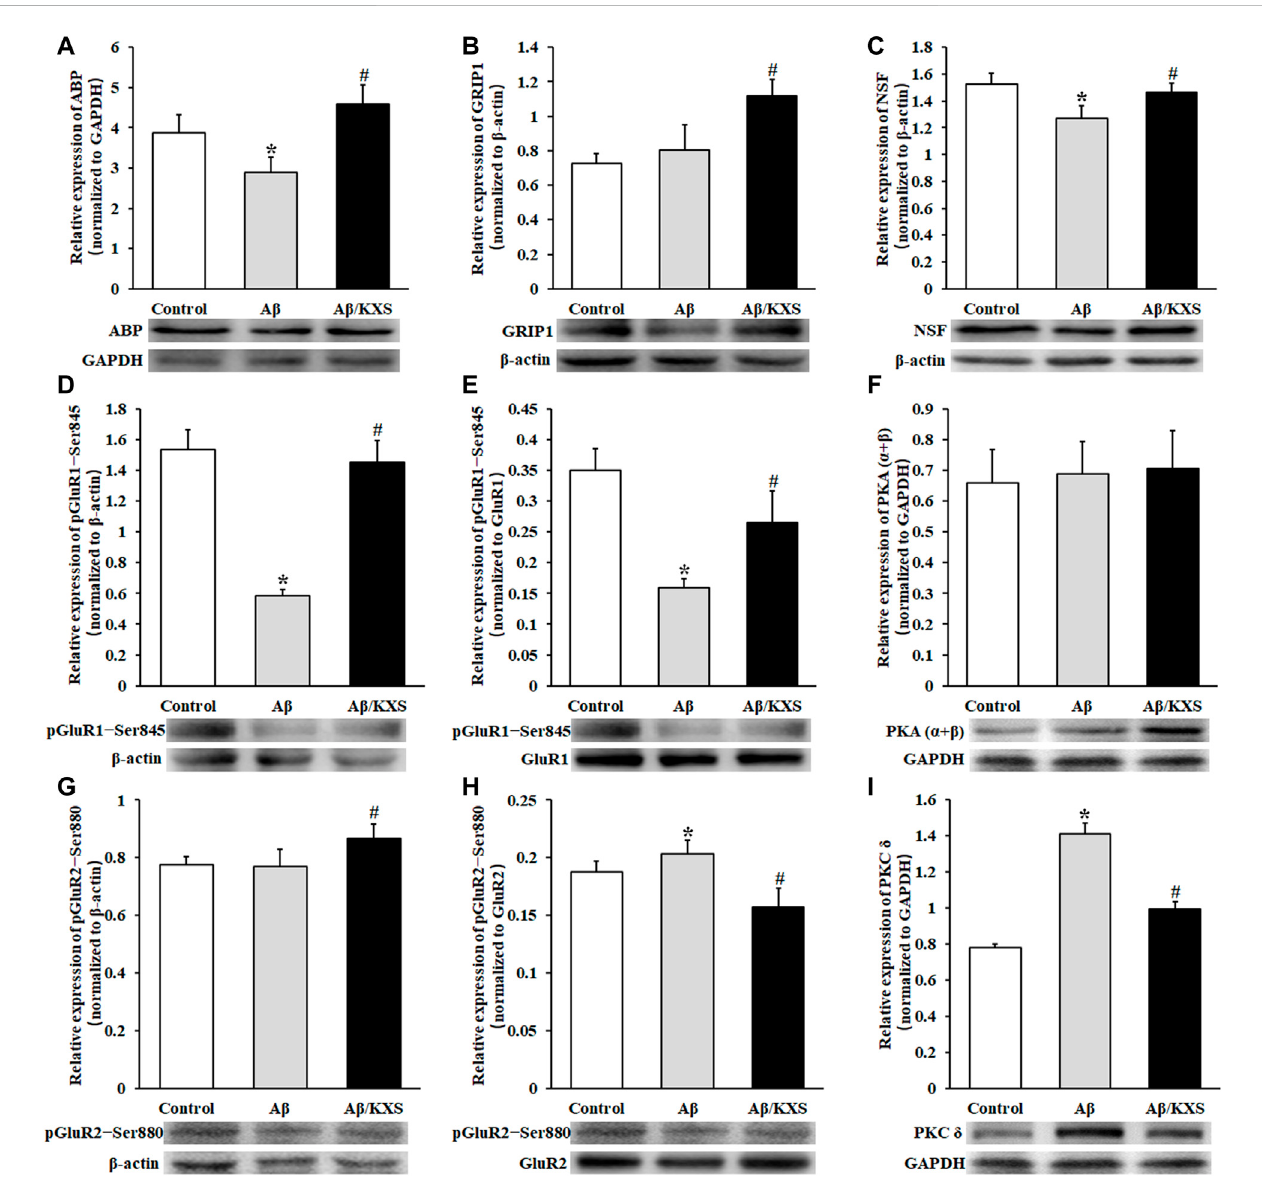
FIGURE 4 Effect of KXS onthe levels of AMPARsubunitsrelated to theprotein expression. The statistical analysis of ABP (A) , GRIP1 (B) , NSF (C) ,pGluR1 – Ser845 (D) , pGluR1 – Ser845/GluR1 (E) , PKA ( α + β ) (F) , pGluR2 – Ser880 (G) , pGluR2 – Ser880/GluR2 (H) , and PKC δ (I) expression was determined using Western blotting. The pictures below the graph indicate the protein exposure; n = 6 per group. Each column with a bar represents the mean ± SD. * p < 0.05 versus the control group;# p < 0.05versustheA β group.Duringtheexperiment,GluR1andpGluR1 – Ser845,aswellasGluR2andpGluR2 – Ser880,wererunsimultaneously onthesame electrophoretic gel; hence, thesameloadingcontrol is usedinFigures3D and4D andinFigures3Eand4G. Themolecularweights ofPKA ( α + β ) and PKC δ are 40 kD and 77 kD, respectively; therefore, they may be separated on one gel and transferred to the same PVDF membrane. The same loading control is used in Figures